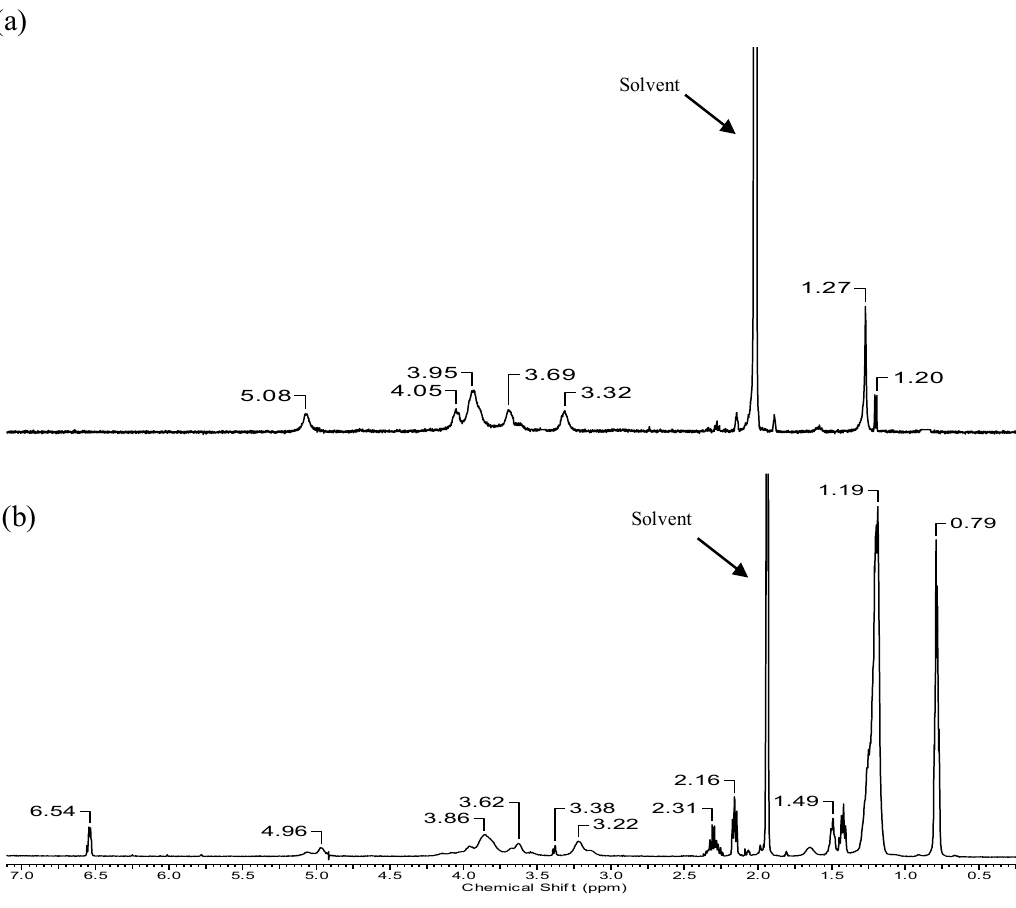
Figure 3: 1 H NMR spectra of (a) chitosan and (b) NOC in acetic acid-d (99.5%).